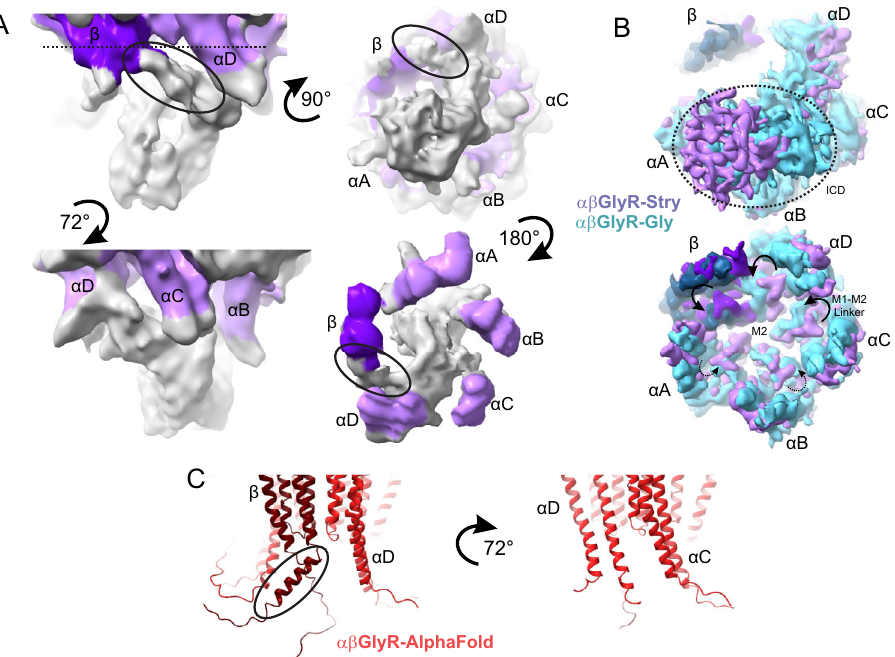
αβ GlyR-Gly). The dotted circle shows the ICD density in the low threshold image, and the arrows show M1 − M2 loop displacement in the high threshold